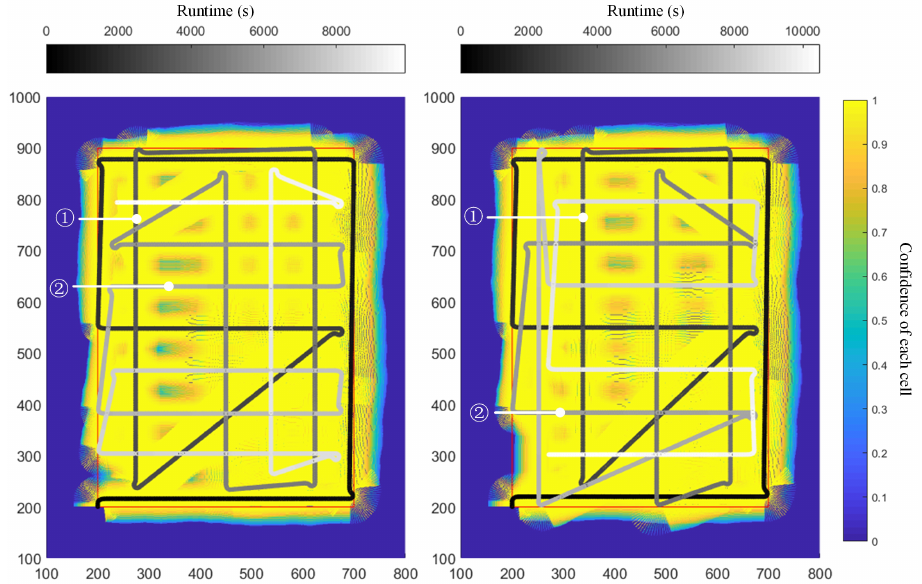
Figure 8. Comparison of the results of run #5( left one ) and run #6 ( right one ). The labeled transects reveal that run #6, which has a larger W e , is more likely to explore distant areas than run